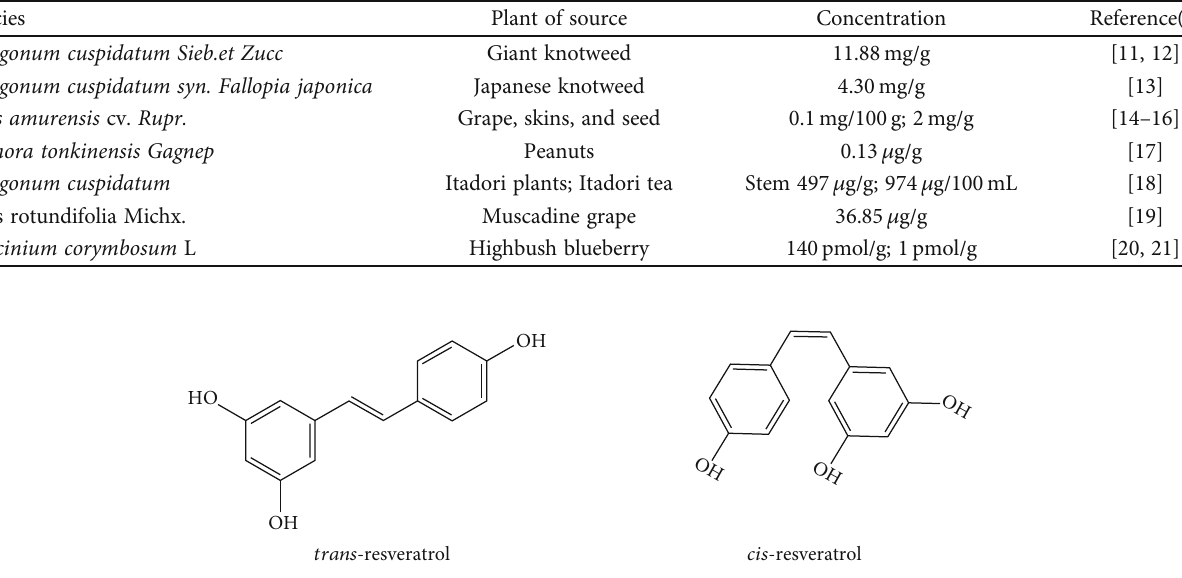
Figure 1: Chemical structures of trans - and cis -resveratrol (3,5,4 ′